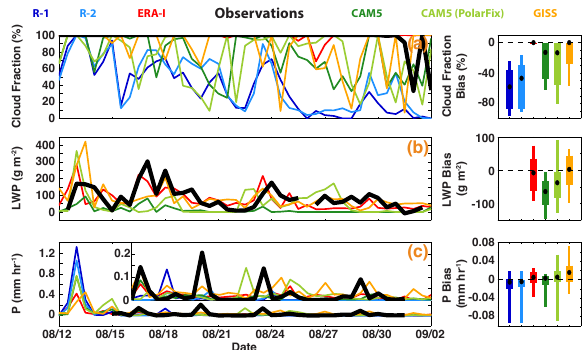
Fig. 3. Time series of common cloud and precipitation quantities (from top to bottom: average cloud fraction, average liquid water path, and average precipitation rate). Included are lines for the ob- servations from Oden (bold black line), CAM5 (standard version, dark green; CAM5-PF, light green), the GISS-ModelE2 (orange), and R-1 (dark blue), R-2 (light blue) and ERA-I (red) reanalyses. The insert in (c) modifies the scale of the vertical axis to better dis- tinguish between models where all have low values. All lines rep- resent six-hour average values. Please note that R-1 and R-2 do not provide liquid water path, and are therefore not included in the cen- ter figure. The right-hand side of the figure includes distributions depicting the median (black dot), IQR (wide bar) and 10th–90th percentiles (thin bar) of the differences between simulated and ob- served